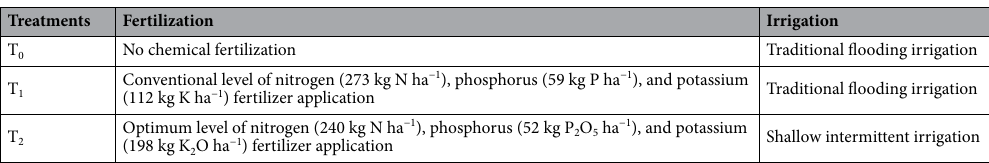
Table 1. Annual water and fertilizer input in Chinese double rice—cropping systems. T 0 = Traditional irrigation; T 1 = Traditional irrigation and fertilization practice; T 2 = Water-saving irrigation and optimizing